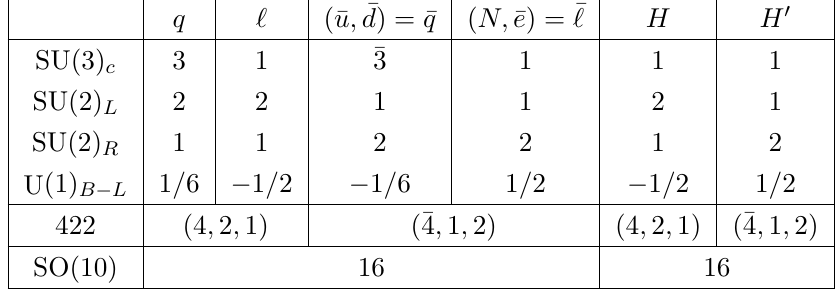
Table 1 . The gauge charges of SM fermions, H and H 0 under 3221 or